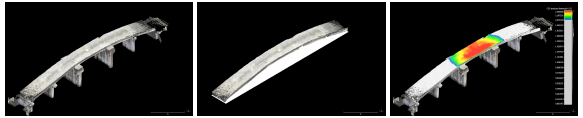
Figure 15. Analyzing the uneven settlement of the deck of a bridge by comparison with horizontal plane Modeling the pagoda by photogrammetric method along with UAV and total station is very efficient, but the problem is how to calculate the tilt of pagoda. We tried to create a cylinder by extruding the circle sharing the same center with the octagonal ground floor plan (figure 16). The point clouds on each floor are then compared to the cylinder to reveal their distance which relates to the tilt of pagoda. But the process if error prone due to a lot of factors: the imperfect geometry of ground floor plan, finding its center and errors in image orientation, etc.